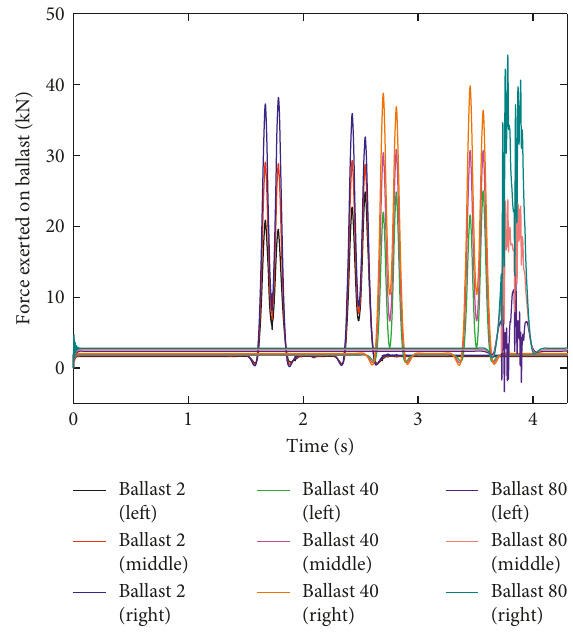
Figure 11: Force exerted on the